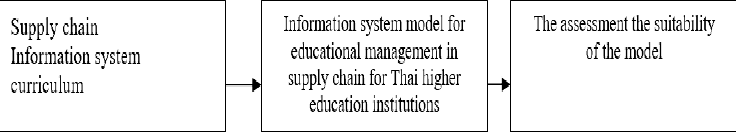
Fig. 1. Conceptual framework about information system model for educational management in supply chain for Thai higher education institutions.